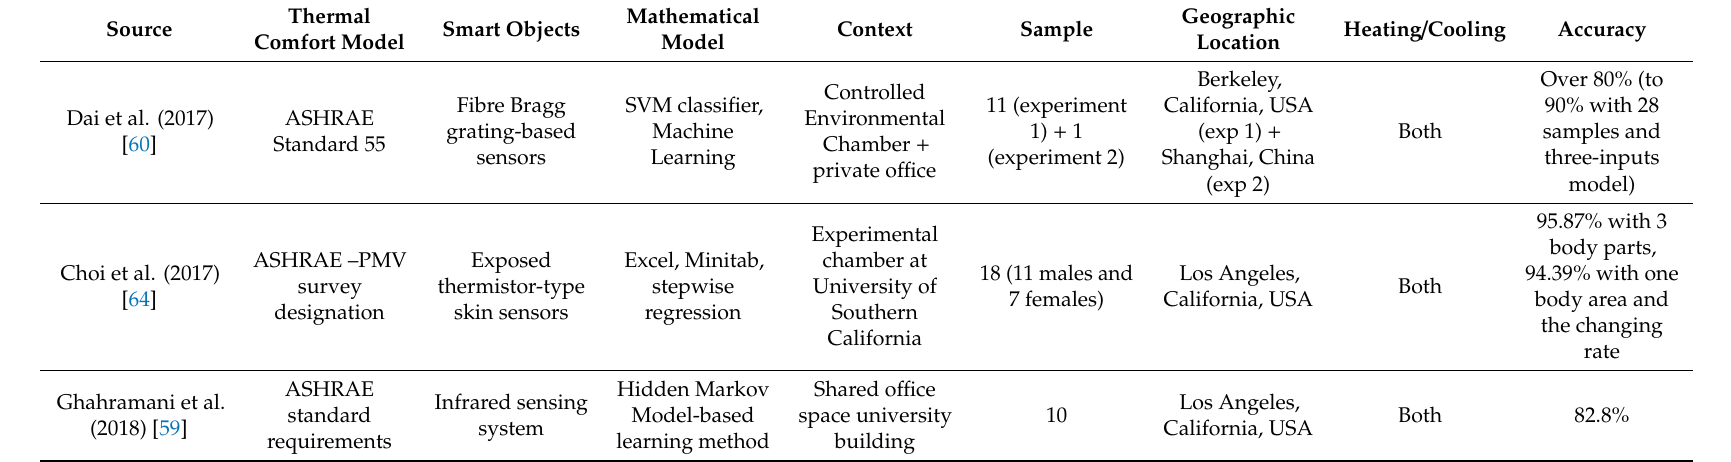
Table 2. Main contributions using IoT objects to monitor thermal